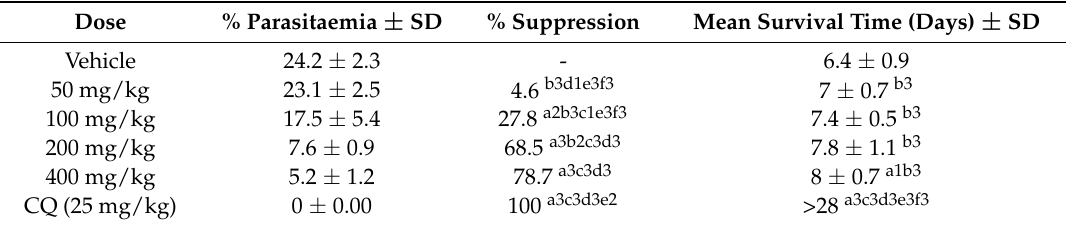
Table 1. Percentage suppression and mean survival time of Plasmodium berghei- infected mice after administration of 80% methanol root extract of Echinops hoehnelii